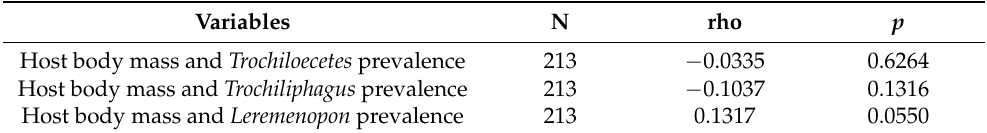
Table 2. Spearman rank correlations between host body mass and the prevalence Trochiloecetes ,